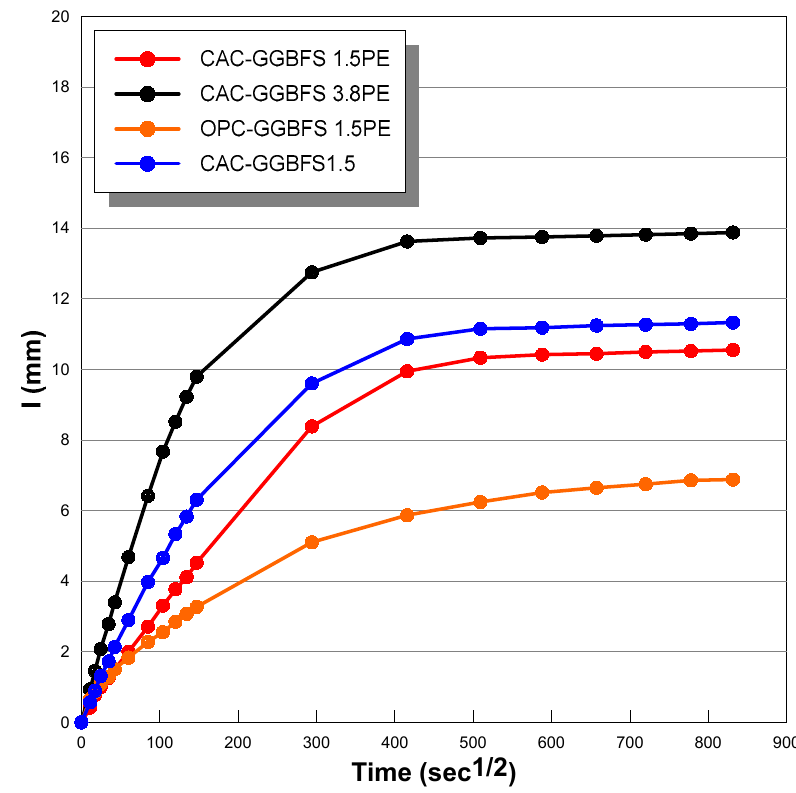
Figure 7. Mass gain verse square root of time (sorptivity test).